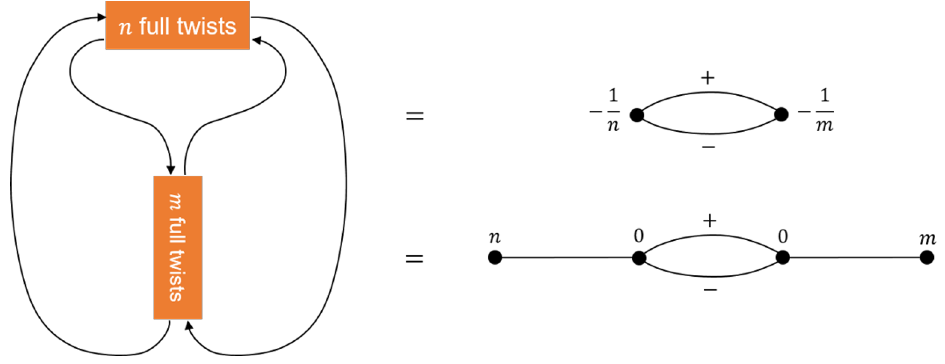
Figure 9 . 0-surgery on a double twist knot K n;m can be represented by a plumbing diagram with one loop. The 5 2 knot is a double twist knot K 2 ; 1